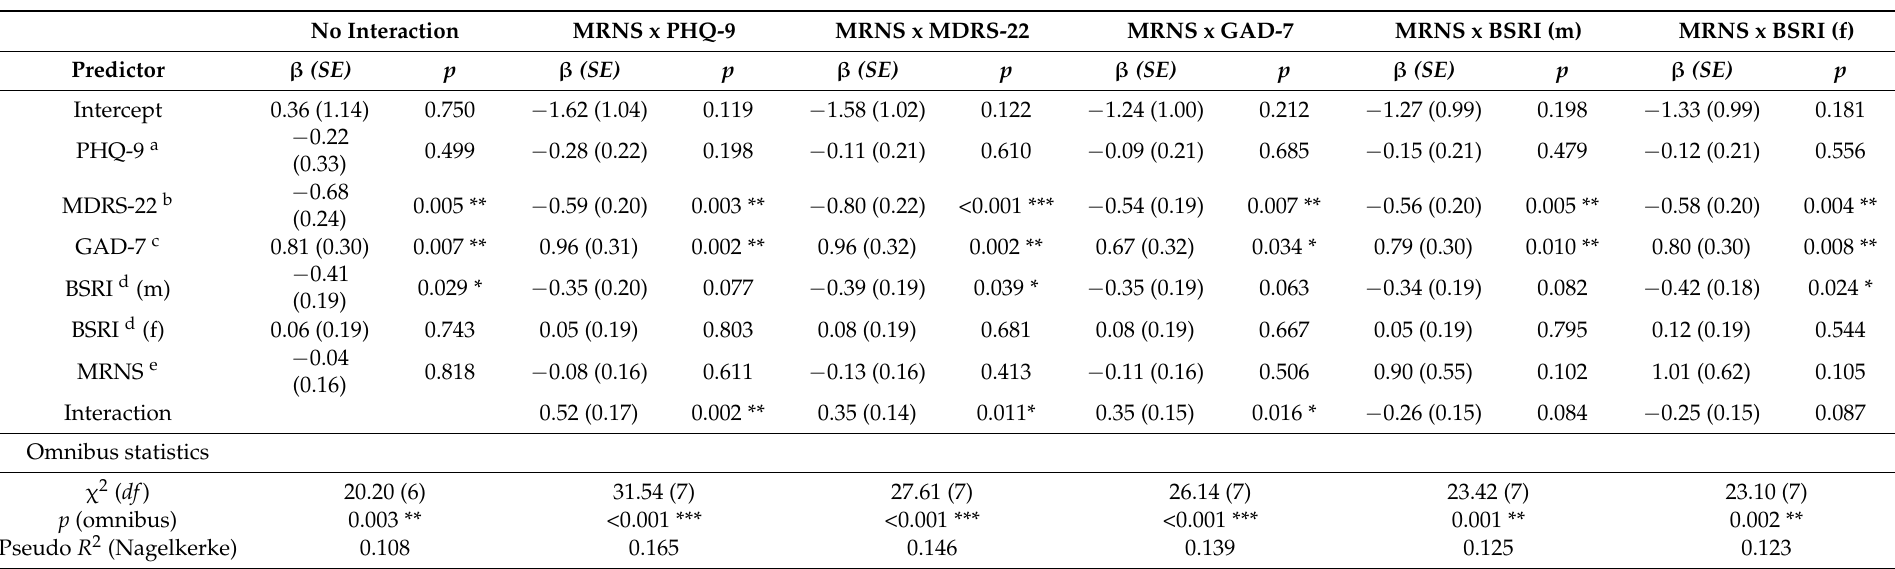
Table 3. Summary of the binary logistic regression models for the male